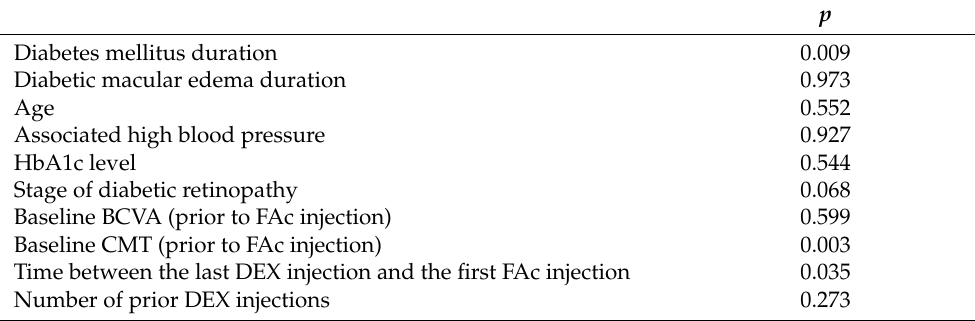
Table 4. Variables associated with the risk of needing additional treatments. BCVA, best-corrected visual acuity; CMT, central macular thickness; DEX, dexamethasone implant; FAc, fluocinolone acetonide